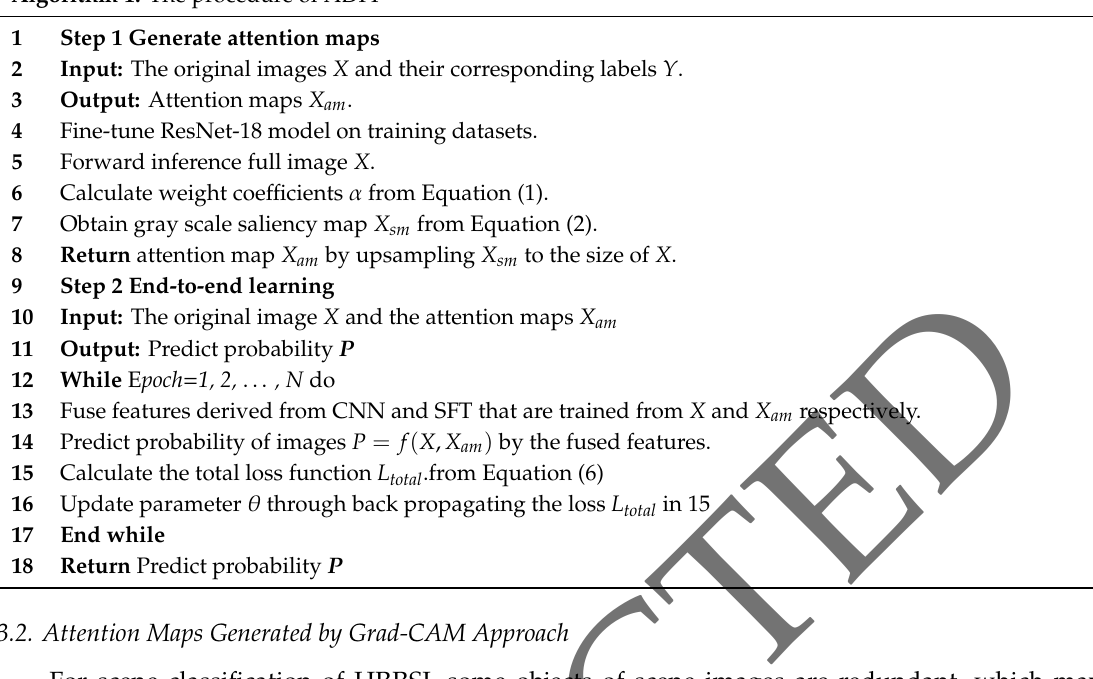
Algorithm 1. The procedure of